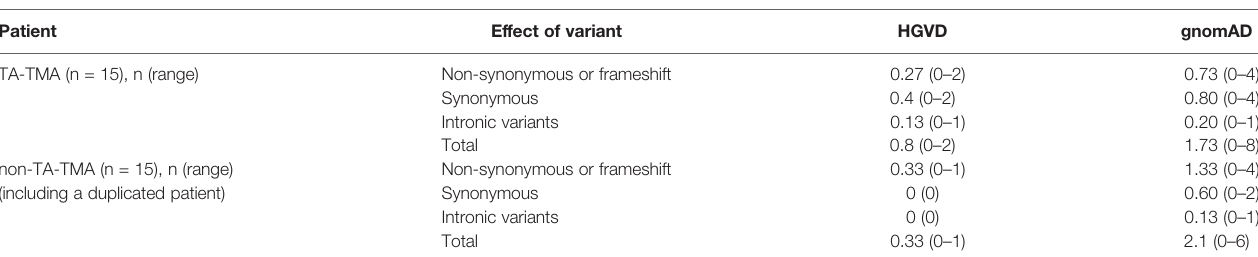
TABLE 3 | Average number of rare variants per